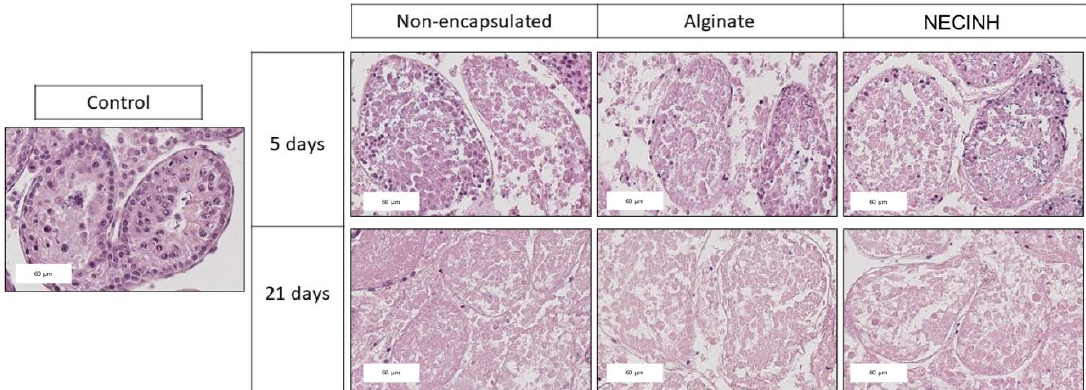
Figure 3. Impact of NECINH-nanoparticles-loaded hydrogel on mice testicular tissue exposed to hypoxia (1% O 2 ) and recovered after 5 or 21 days. Three conditions were compared for each timing (non-encapsulated, encapsulated in alginate, and encapsulated in alginate with NECINH NPs). Hematoxylin-eosin staining was used for the evaluation of STs (seminiferous tubule sections) morphology. Scale bar = 60 μm.